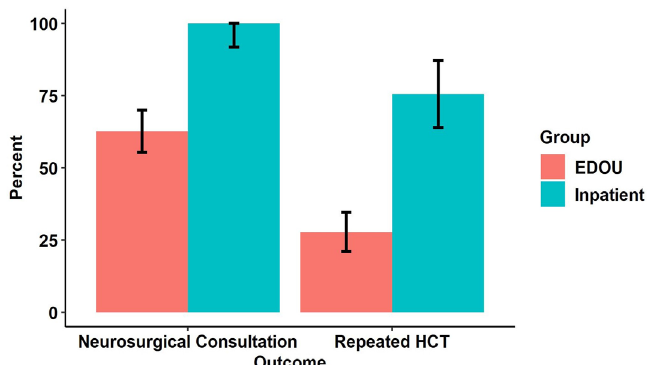
Figure 2. Graphic representation of difference in neurosurgical consultation and repeat head computed tomography between intervention (EDOU) and control (Inpatient) groups. HCT , head computed tomography; EDOU , emergency department observation